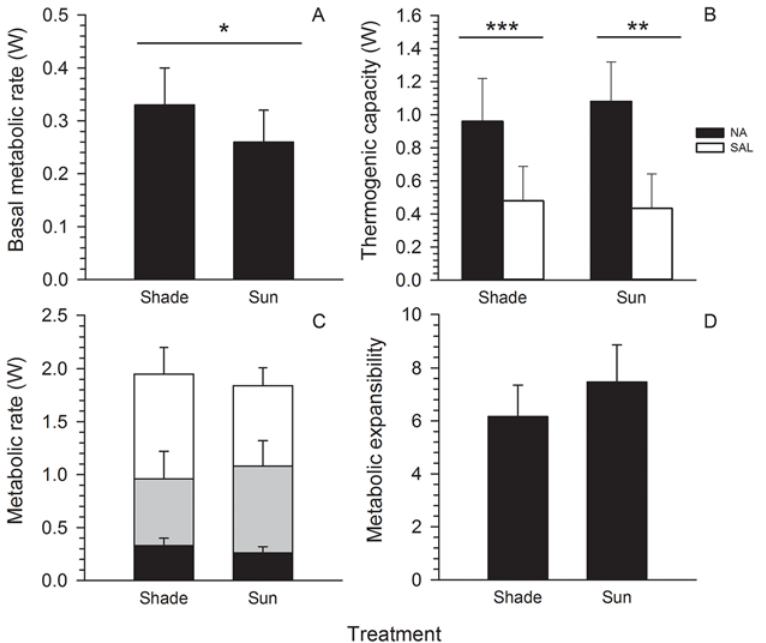
Fig 4. Metabolic rates. Basal metabolic rate (BMR), non-shivering thermogenesis (NST) capacity and summit metabolism ( M sum ) in eastern rock elephant shrews ( Elephantulus myurus ) housed in outdoor cages with exposure to natural (100%, “ Sun ” ) or experimentally reduced (approximately 20%, “ Shade ” ) levels of solar radiation. Panel A: BMR; panel B: metabolic rate induced by either noradrenalin (NA) or a control saline (SAL) injection during measurements of NST, panel C: BMR (black), NST capacity (grey) and M sum (white); panel D: metabolic expansibility (i.e., M sum / BMR).